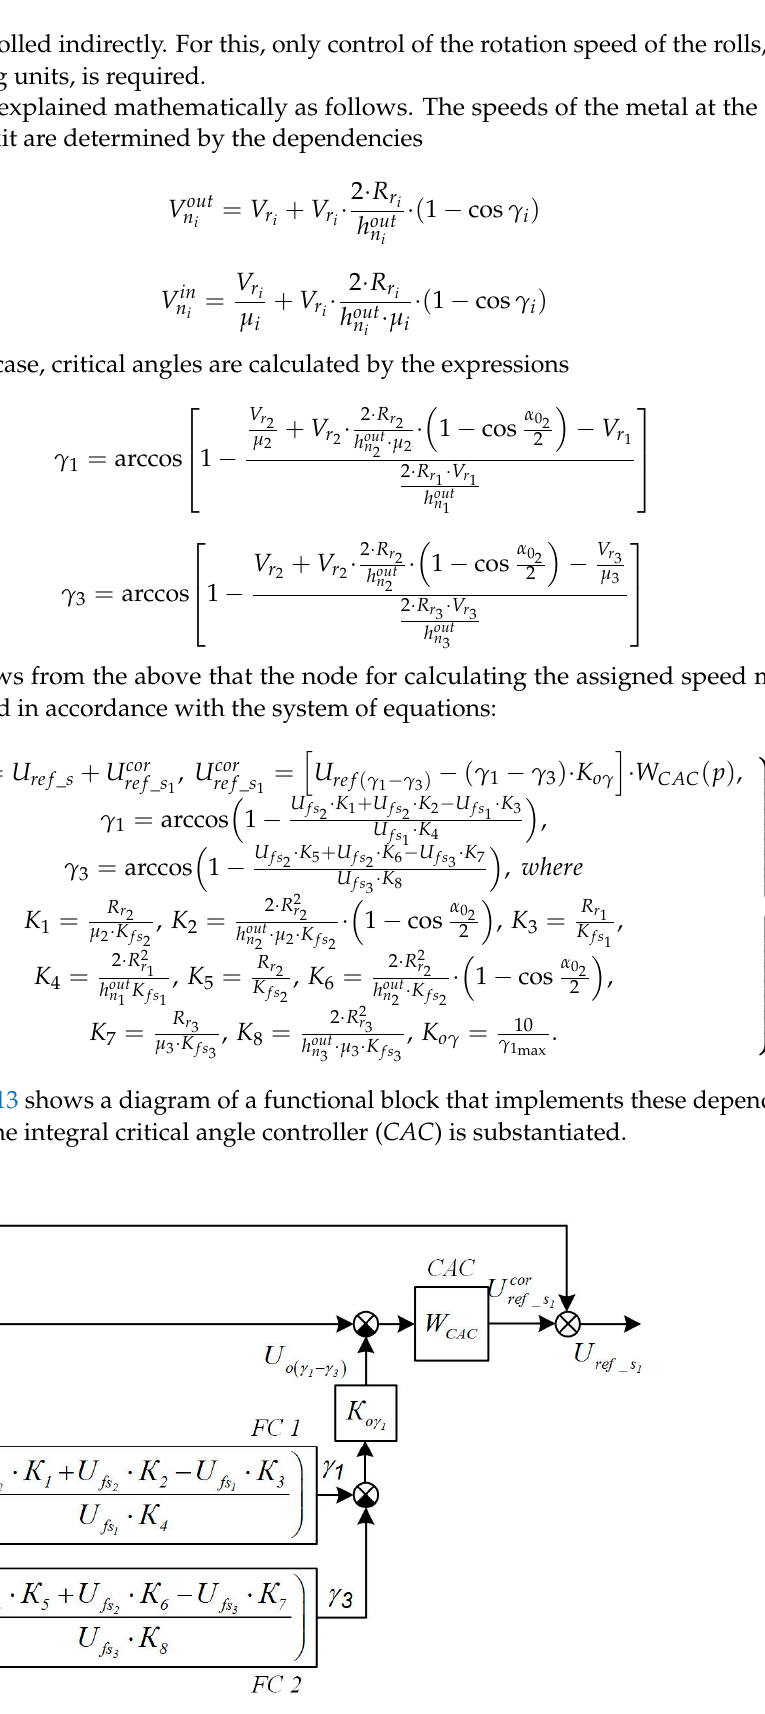
Figure 13. Functional diagram of the block for calculating the assigned speed CAC (critical angle controller).